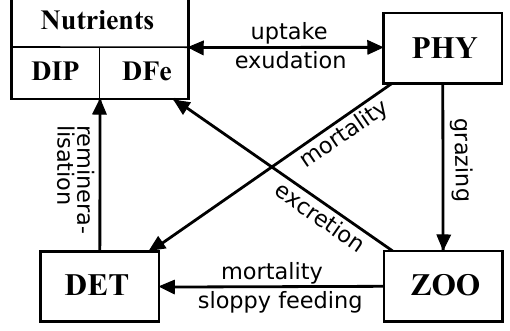
Fig. 1. Ecosystem